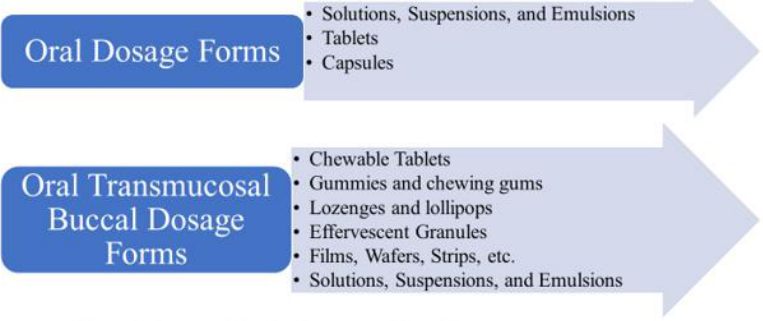
Figure 2. Pharmaceutical oral and transmucosal buccal dosage form.